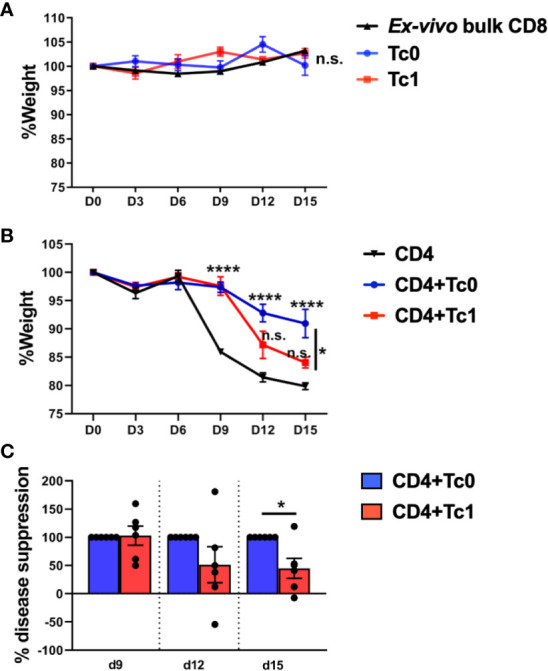
Naïve-derived Tc1 cells have deficient ability to suppress xGVHD in vivo. xGVHD was induced in 6–8-week-old female NSG mice by injecting bulk ex vivo-purified CD4+CD25- human T-cells with or without in vitro-generated, naïve-derived Tc0 (control), and Tc1 cells at a ratio of 1:1 (10 million cells each). Mice were monitored for weight loss over 15 days. Panels (A, B) show % weight (normalized to day 0) ± SEM. Panel (A) represents absence of xGVHD when only CD8+ T-cells were injected, either as ex vivo-purified bulk CD8+ T-cells (two independent replicates; n = 5 mice) or as in vitro-differentiated Tc0 or Tc1 cells (1 experiment, n = 3 mice each). Panel (B) demonstrates CD4-induced xGVHD with CD4+ T-cells alone or admixed with indicated Tc cells (two independent replicates; n = 6 mice per group). Panel (C) shows the same data represented as calculated % disease suppression on d9, d12, and d15 normalized to the Tc0 control group designated as “100% suppression”. *p < 0.05 and ****p < 0.0001; n.s., not significant. (A, B) Two-way ANOVA using Tukey’s multiple comparisons test and (C) unpaired t-test.